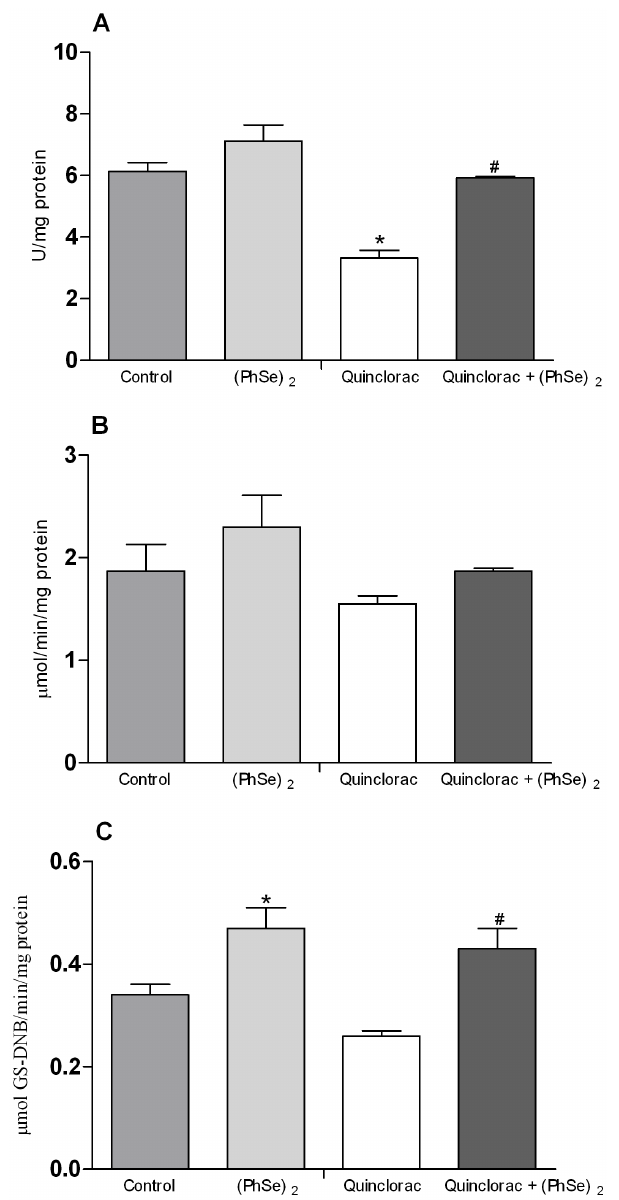
Figure 2. Antioxidants parameters. SOD (A), CAT (B), and GST (C) in liver of silver catfish fed for 60 days with diets containing 0 or 3.0 mg/Kg of (PhSe) 2 and after exposed to quinclorac herbicide or to control conditions. Data are reported as mean ¡ SEM (n 5 12). (*) P , 0.05 as compared with the control group. ( # ) P , 0.05 as compared with the quinclorac